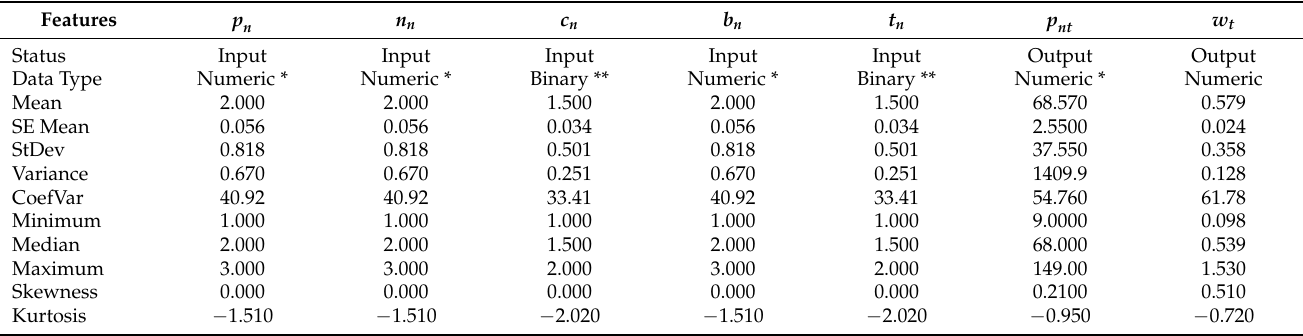
Table 2. The statistical characteristics of the input and output variables.